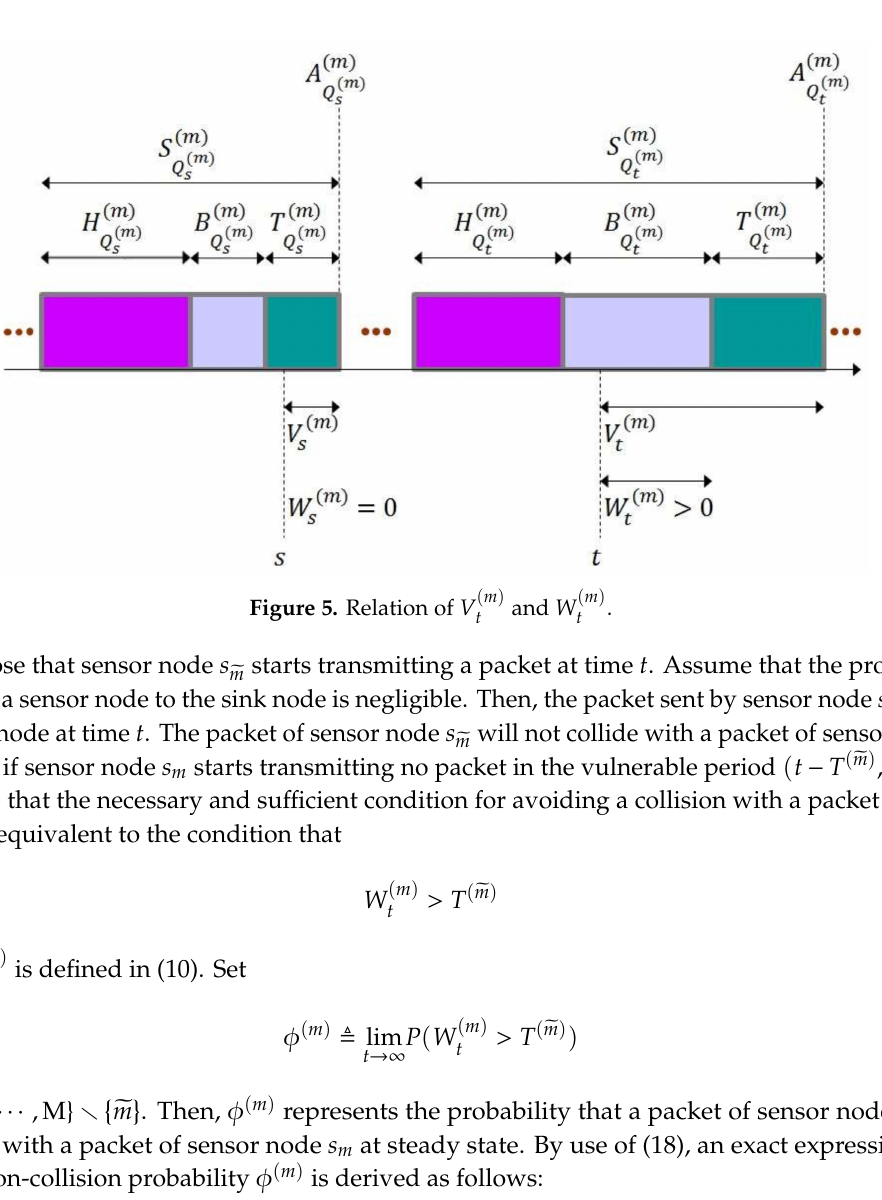
Figure 5. Relation of V